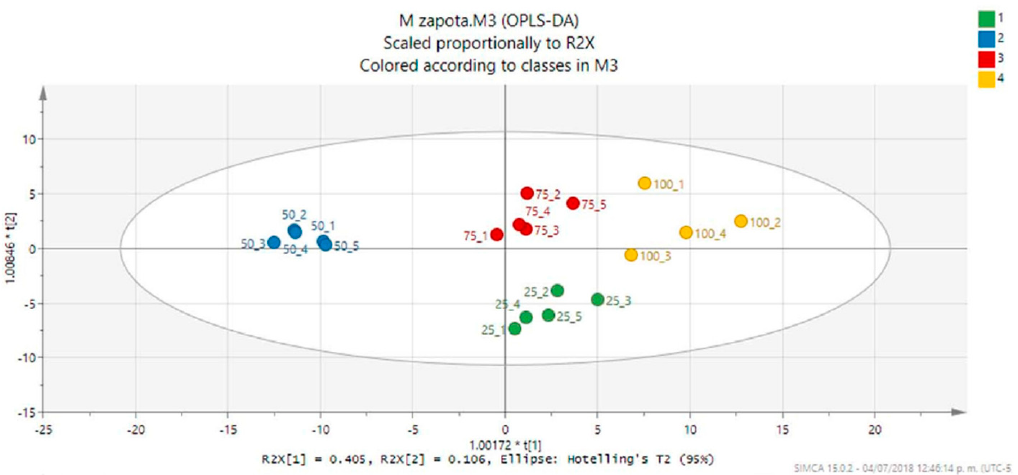
Figure 4. Orthogonal projections to latent structures discriminant analysis (OPLS-DA) score plot (PC1 vs. PC2, 42% of the explained variance) of the M. zapota leaf extracts (MZ25, green; MZ50, blue; MZ75, red; MZ100, yellow). The ellipse represents the Hotelling T2 with 95% confidence in the score plot.